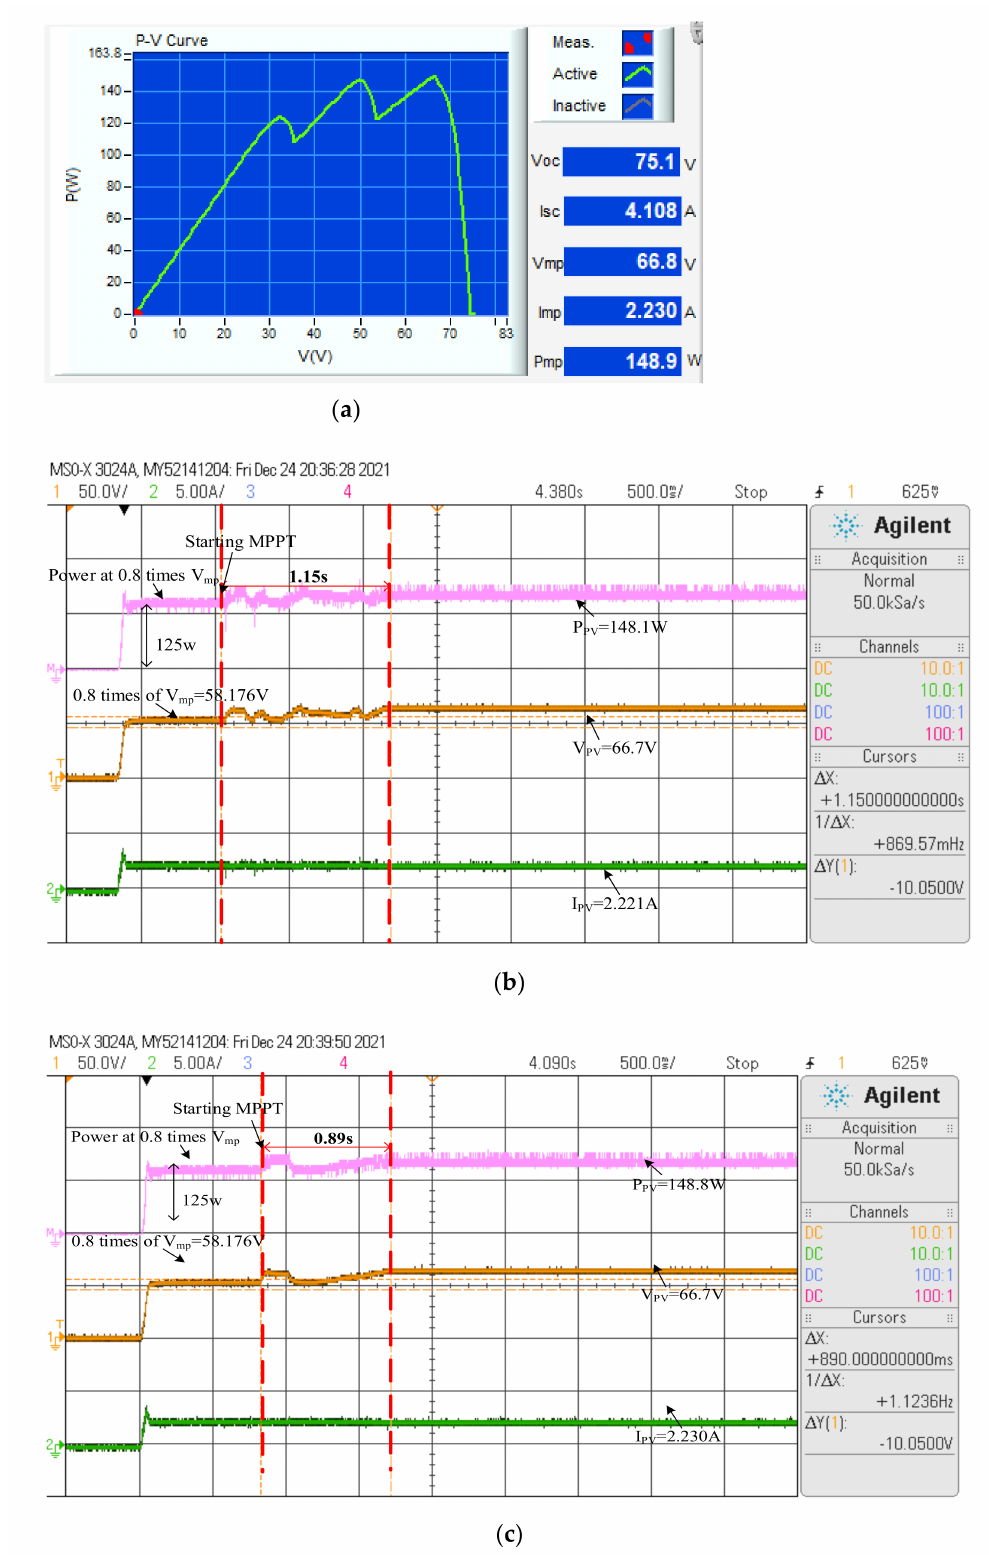
Figure 18. Test results of the MPPT of photovoltaic module array in Case 3: ( a ) P-V characteristic curve; ( b ) tracking curve of the traditional ABC algorithm ( P mp = 148.1 W); ( c ) tracking curve of the I-ABC algorithm ( P mp = 148.8